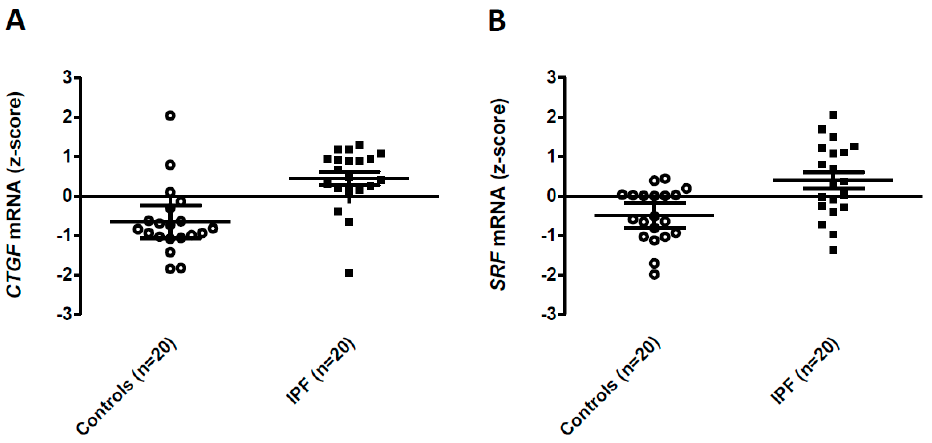
Figure 1. Expression levels of CTGF ( A ) and SRF ( B ) in Control and IPF fibroblasts. Data were obtained from the Gene Expression Omnibus GSE1724, GSE10921, GSE40839 and GSE44723 dataset and transformed to z-scores. Expression of CTGF and SRF mRNAs is shown as individual values, medians and 95% confidence intervals.